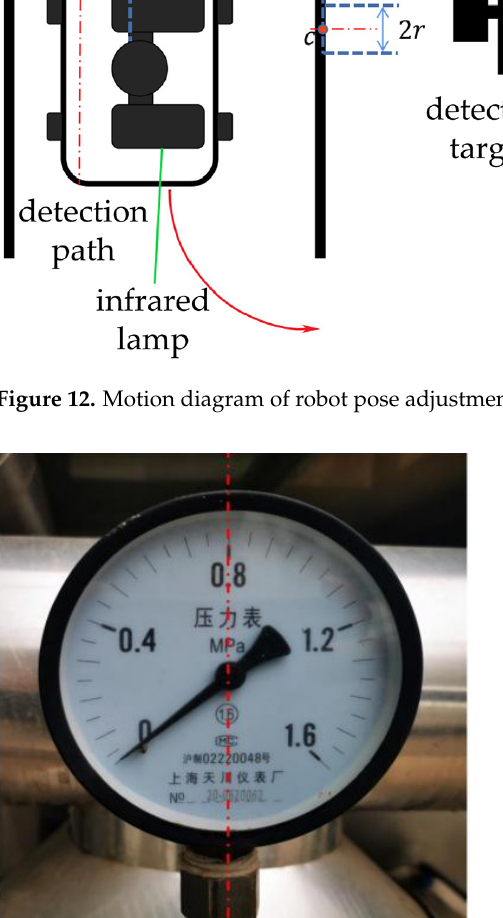
Figure 12. Motion diagram of robot pose adjustment.